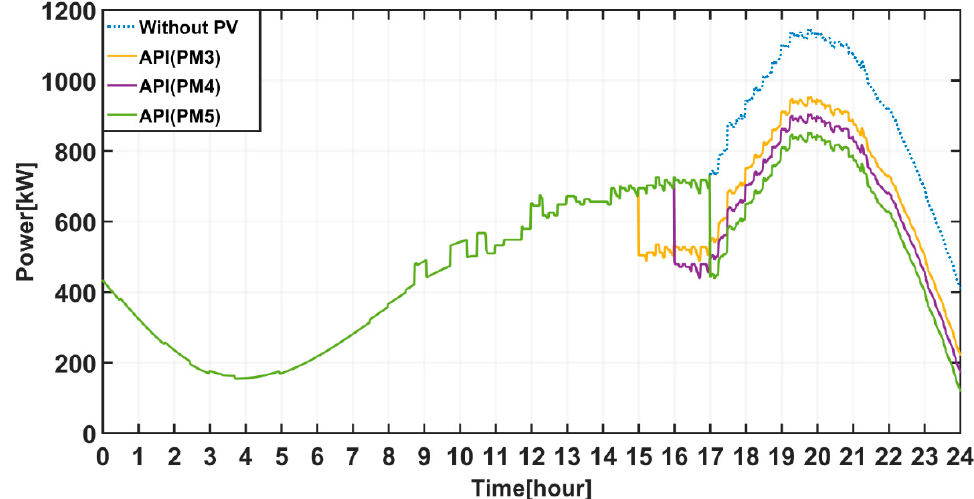
Figure 10. Effect of different discharging time to DT loading (EV penetration ratio: 20%).